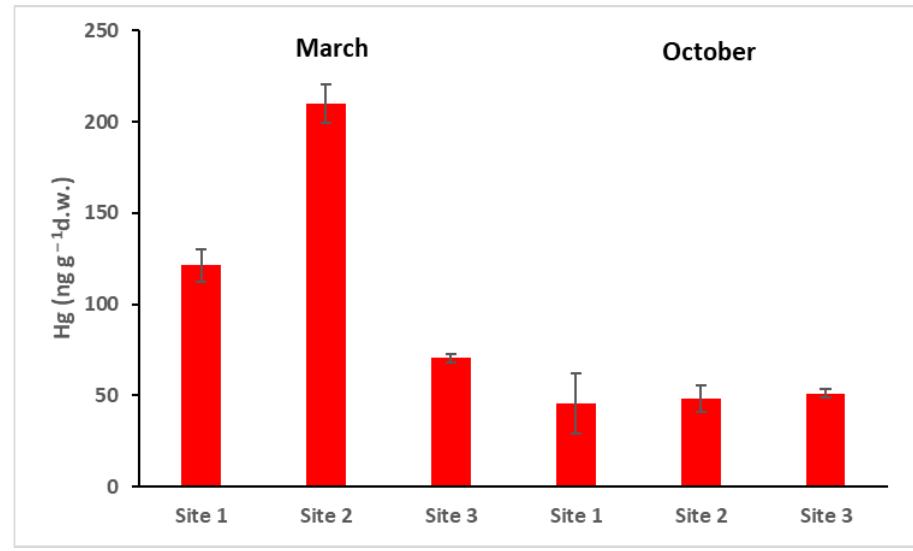
Figure 6. Total Hg in the biofilm. Site 1 (Villadossola), Site 2 (Bosco Tenso), Site 3 (Ornavasso). Dry weight = d.w.